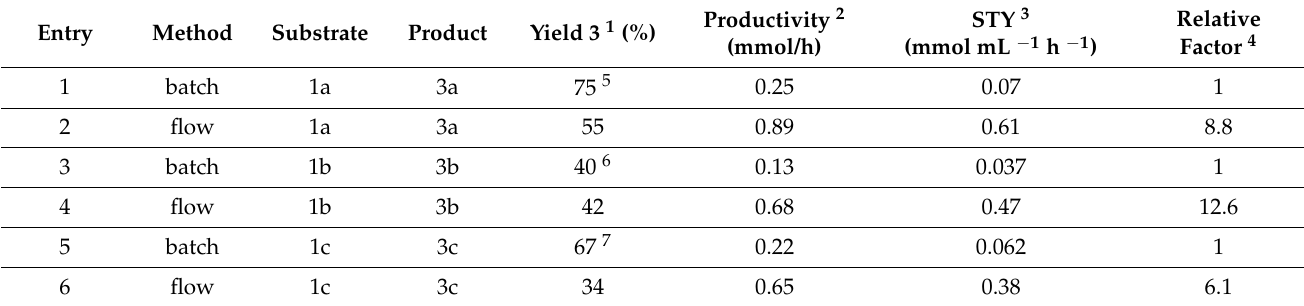
Table 4. Numerical comparison of performances of reaction in batch and in